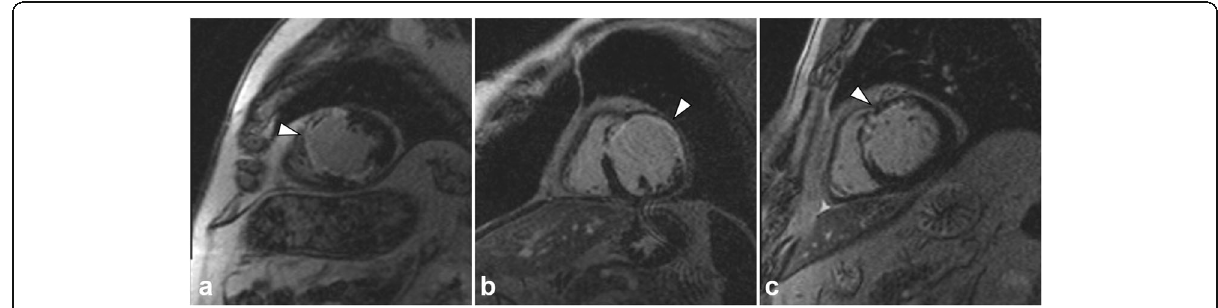
Fig. 3 Inversion recovery sequences for late gadolinium enhancement performed using 0.10 ( a ), 0.15 ( b ), or 0.20 ( c ) mmol/kg of gadobutrol, in male patients of 76, 54, and 49 years of age, respectively, matched for percentage infarct